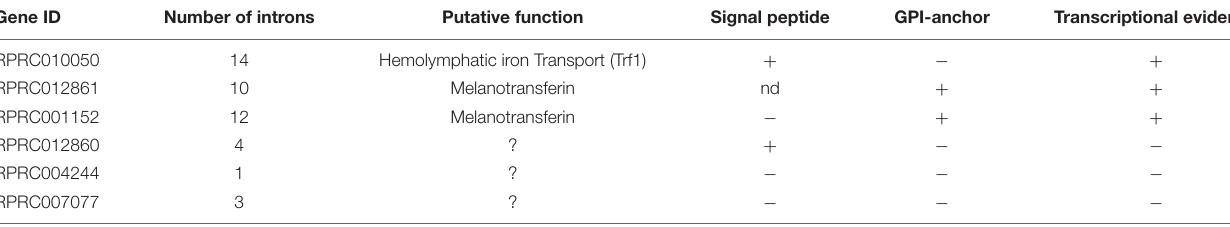
TABLE 1 | Transferrin superfamily genes identified in the Rhodnius prolixus genome.